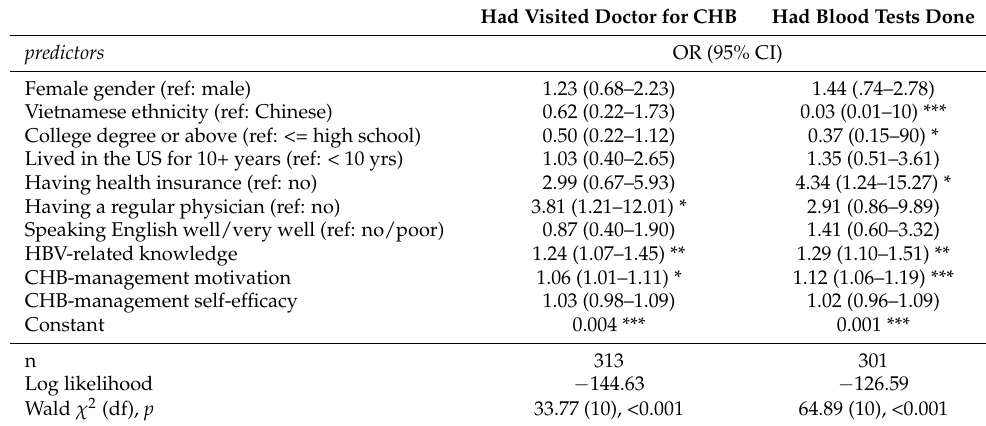
Table 3. Multivariate logistic regression results on doctor visit and blood